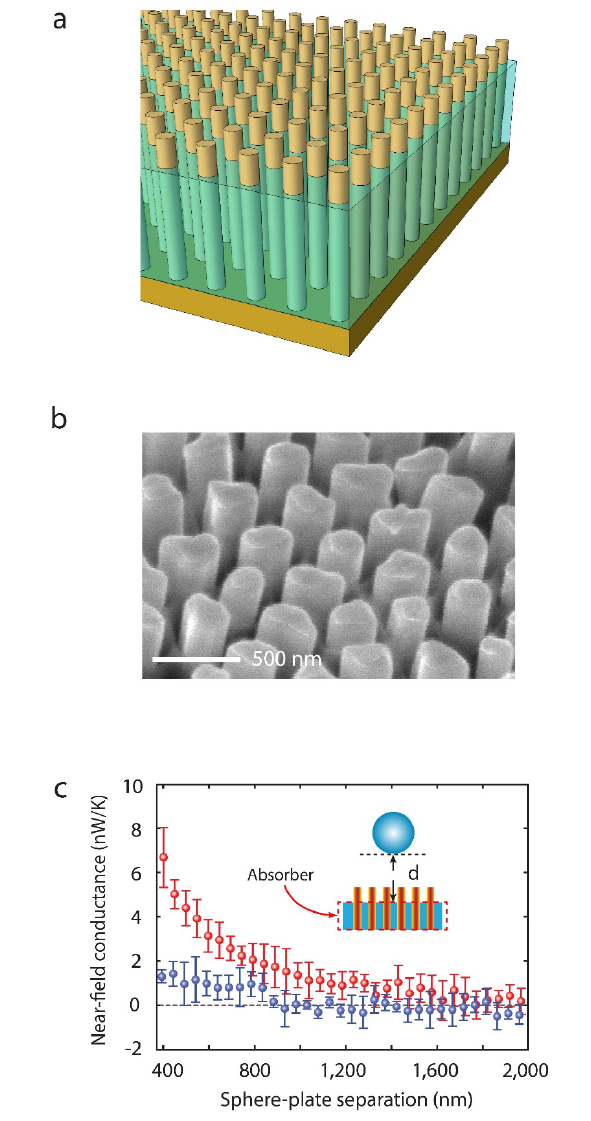
Figure 10: Experimental demonstration of near-field thermal ex- traction. (a) Schematic and (b) SEM image of partially released nickel nanowire arrays. The protruded nanowires are measured to be ~400 nm from the anodic aluminum oxide (AAO) template. (c) Near-field heat transfer as a function of the gap between the sphere and the AAO template with (red dots) and without (blue dots) the protruded nanowires. The dashed line indicating zero near-field conductance is drawn for eye guidance. The separation between the sphere and the substrate (AAO template) ends at ~400 nm because of the protruded nanowires